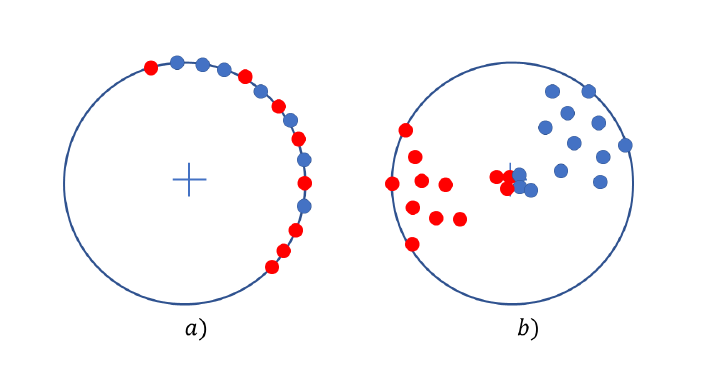
Figure 3. ( a ) Points in the original embedding space lie in the unit hypersphere S d − 1 ⊂ R d , represented by the circumference, words are not grouped by polarity. ( b ) After applying the transformation R , the points R ( w ) lie inside the closed unit ball B d , represented by the closed circle, points are now grouped by